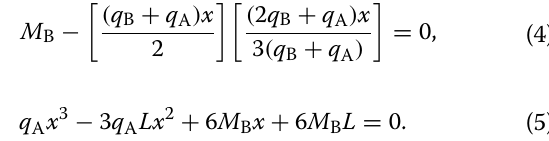
body diagram remain in static equilibrium.